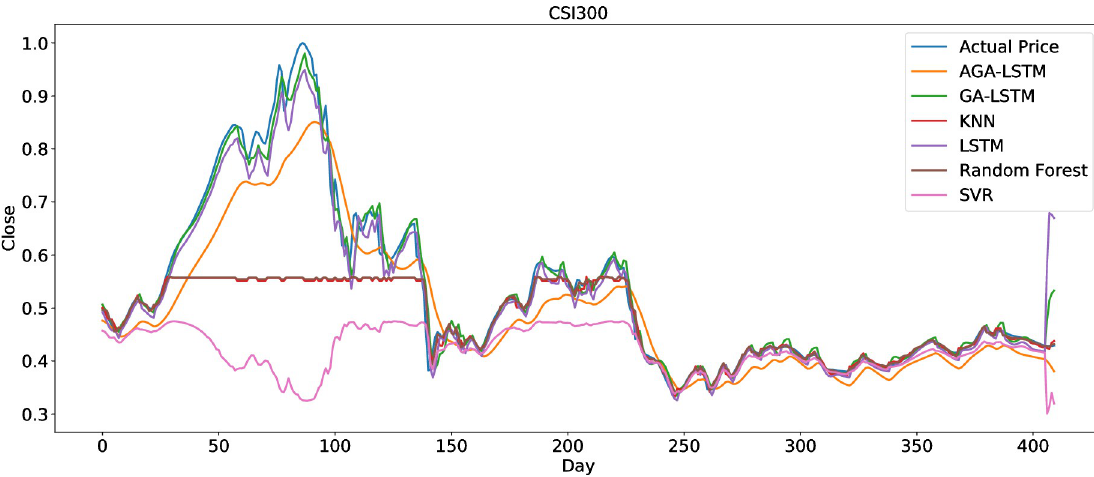
Fig 22. Comparison of AGA-LSTM and other DL models in CSI300 data set.